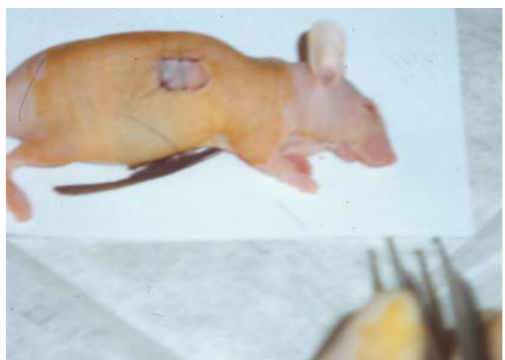
FIGURE 2 – Suture of the cultured composite graft onto the dorsum of the athymic mice.